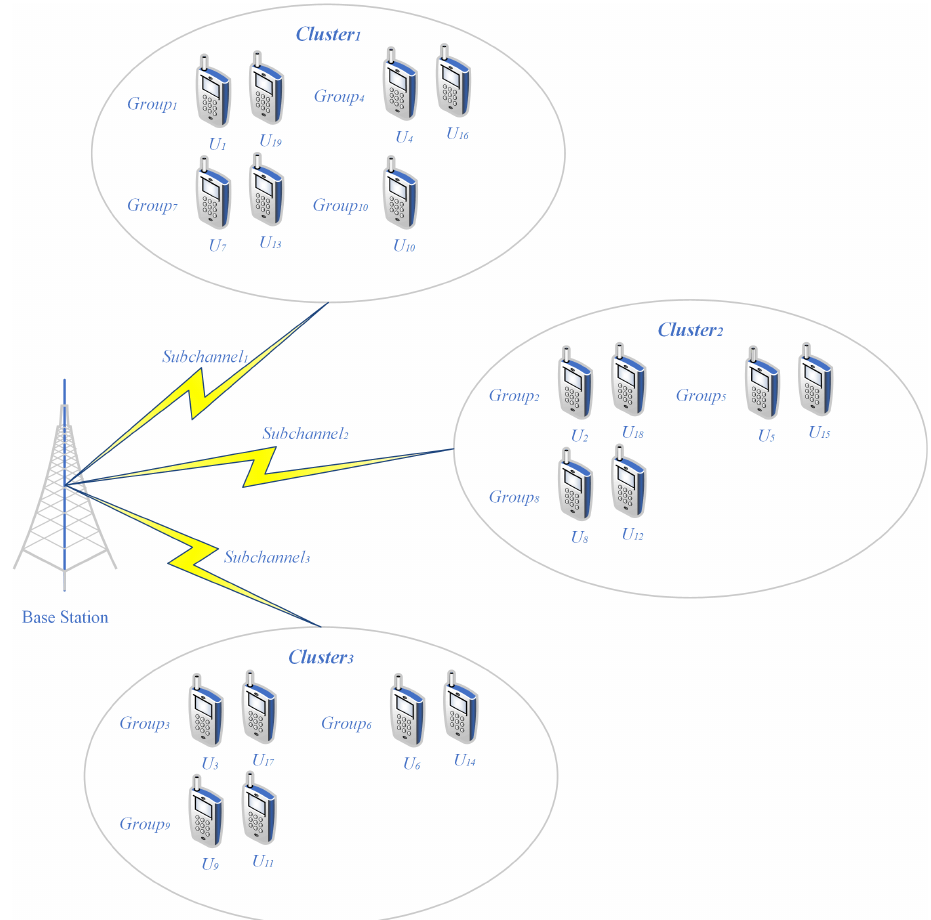
Figure 2. An example result of allocating 19 users into three